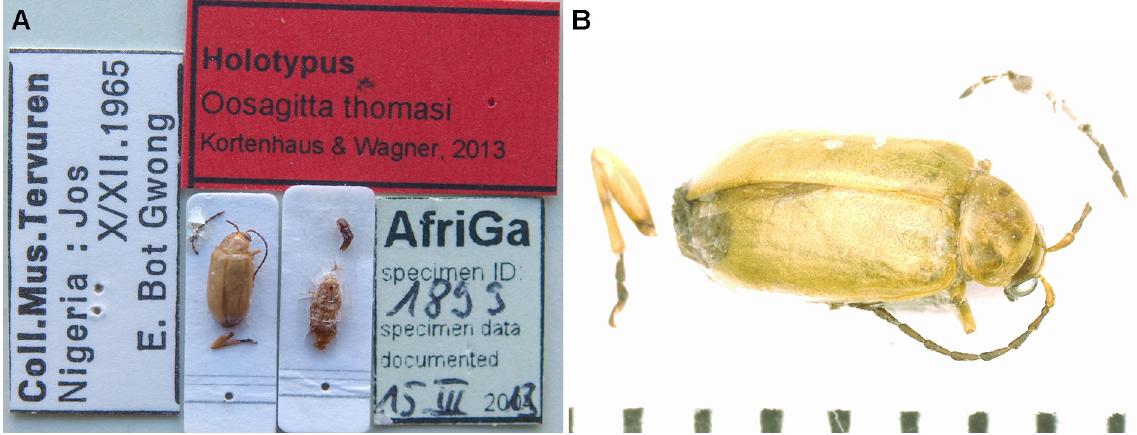
Fig. 26. Holotype of O. thomasi sp. nov. A . Overview with labels. B . Close-up of